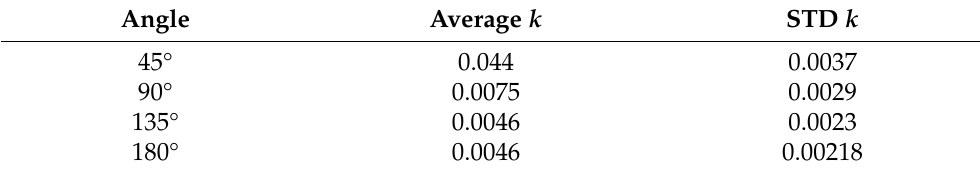
Table 1. Average coupling factors of coil pairs with the four angular